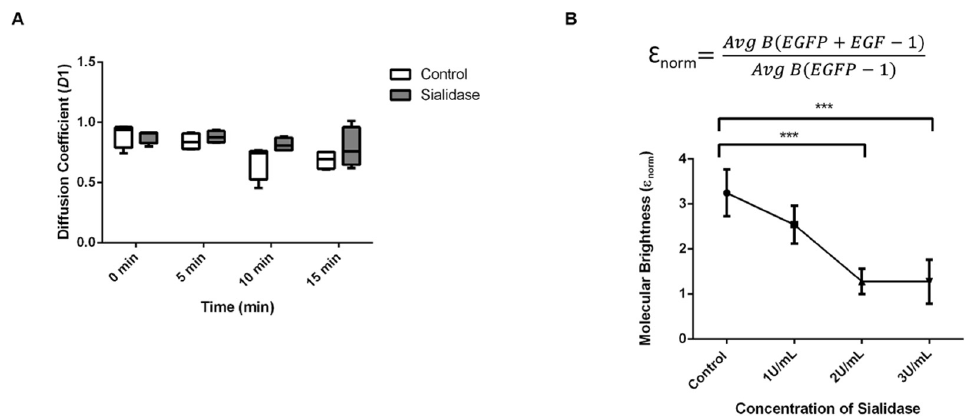
Figure 6. RICS measurement and N&B analysis of EGF-induced EGFR-GFP clustering in EGFP-KI cells treated with and without sialidase. ( A ) Confocal fluorescence images of EGFP-KI cells treated with and without sialidase prior to EGF stimulation. RICS images of the selected region of interest (ROI; yellow box) were acquired for N&B analysis; ( B ) N&B analysis of the ROI at intervals of 5 min after EGF treatment in the control and sialidase-treated EGFP-KI cells. The red boxes in the intensity maps represent monomeric EGFR-GFP defined by the mock control group for ease of comparison